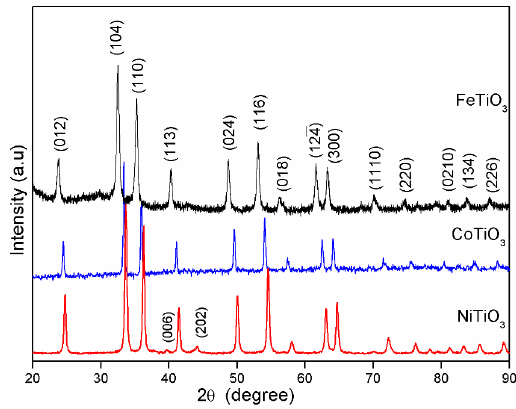
(b) CoTiO and 3 3